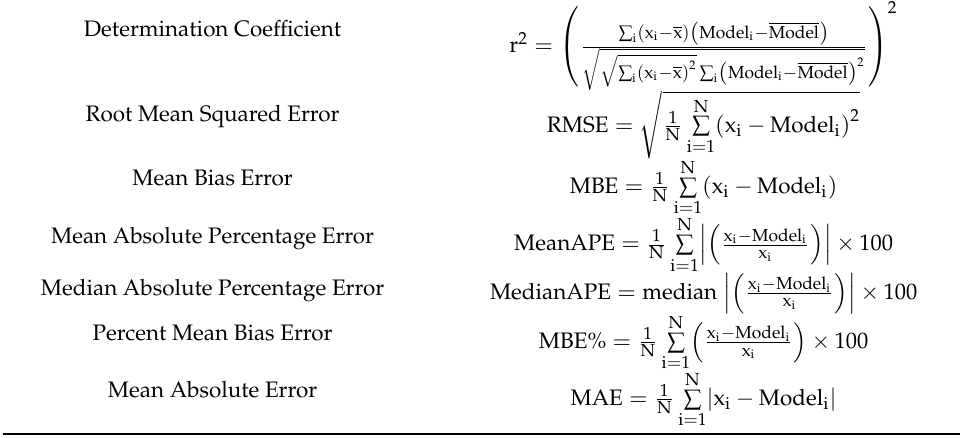
Table 1. Statistical parameters used for the L4 SSS regional and global product validation. Determination